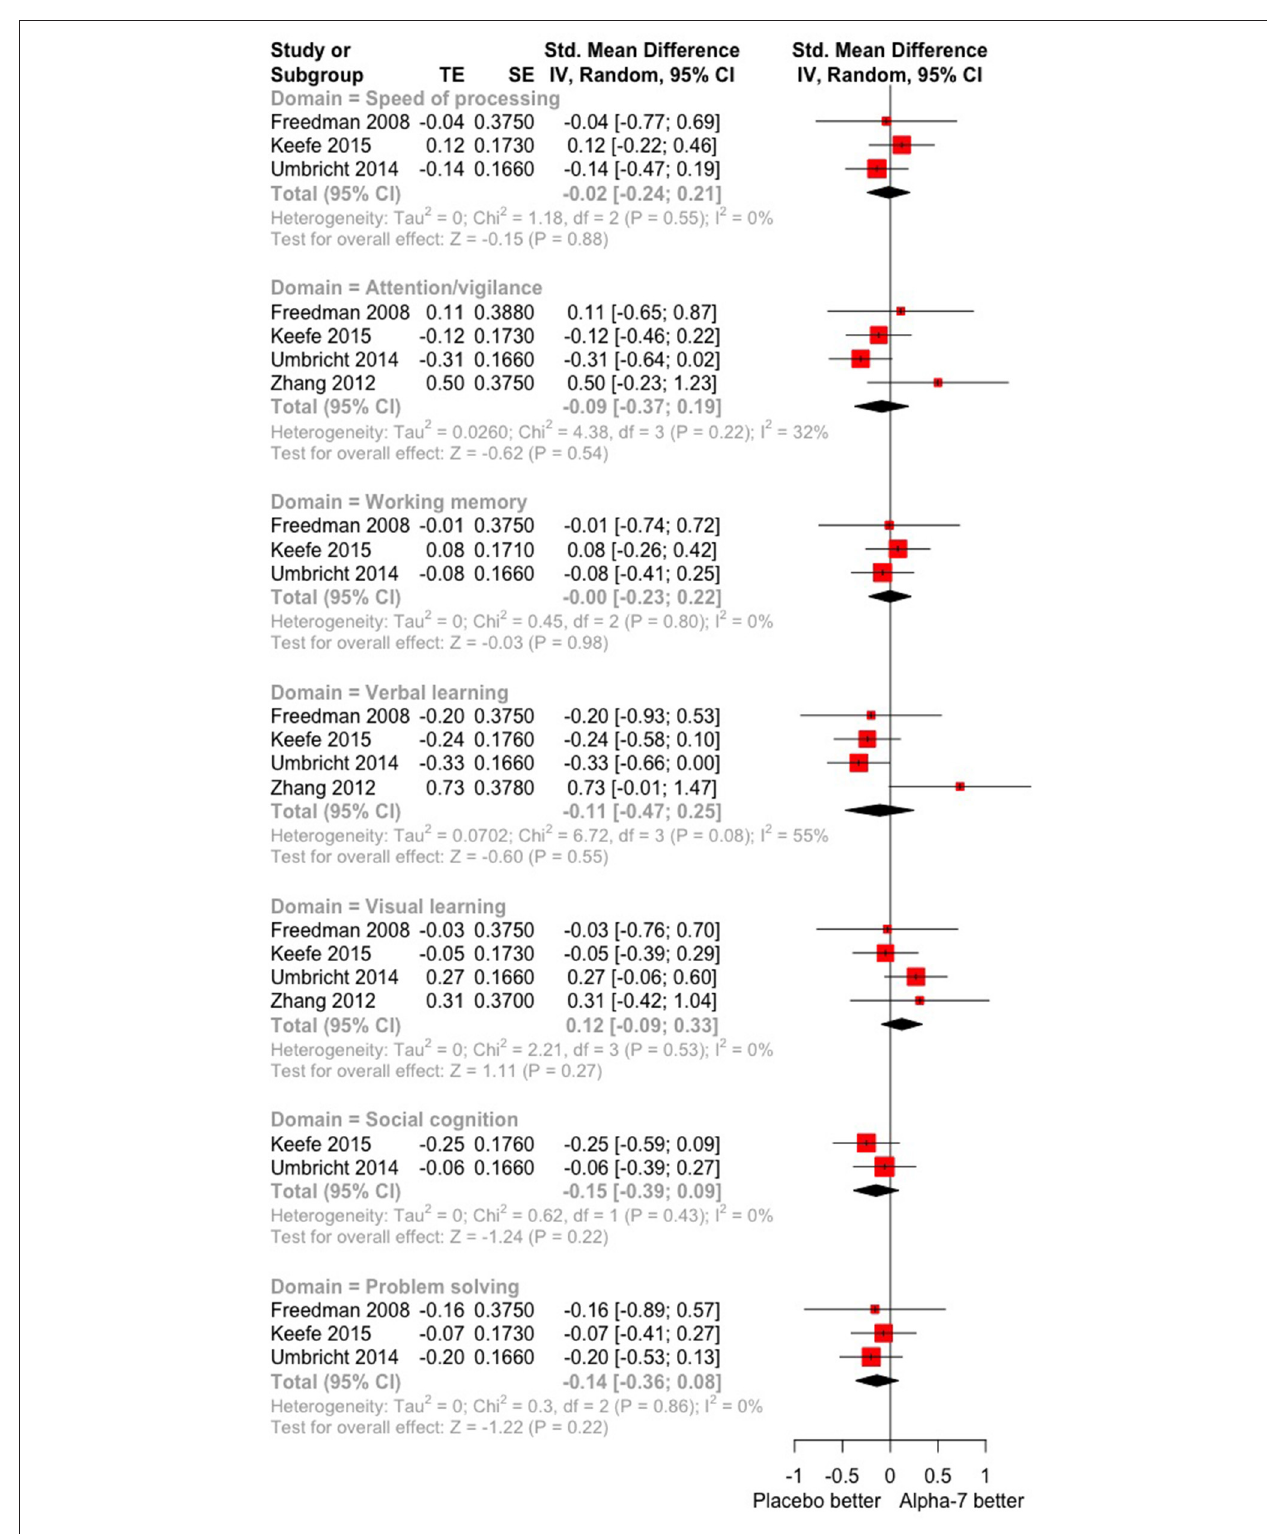
Frontiers in Psychiatry |